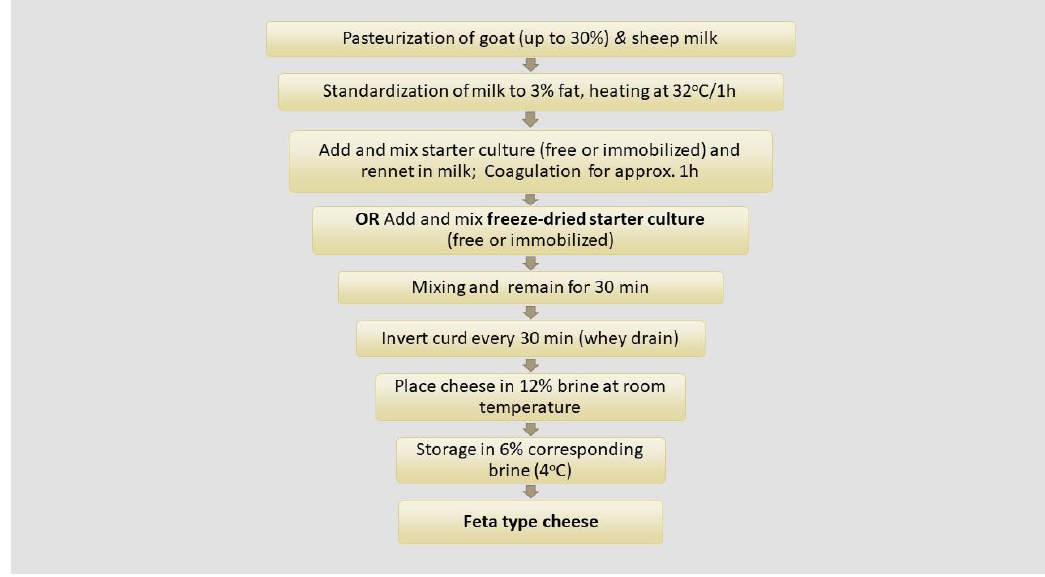
Figure 1. Diagram of Feta-type cheese production.